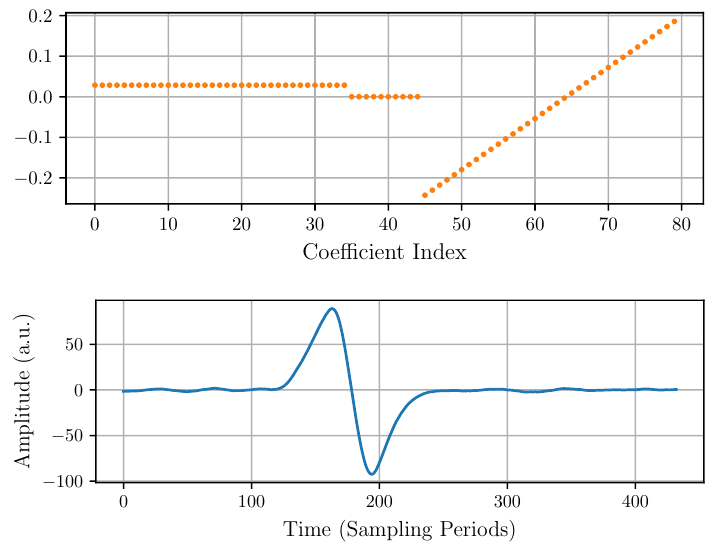
Figure 6. GD FIR coefficients ( top ) and the output pulse corresponding to an experimental input pulse ( bottom